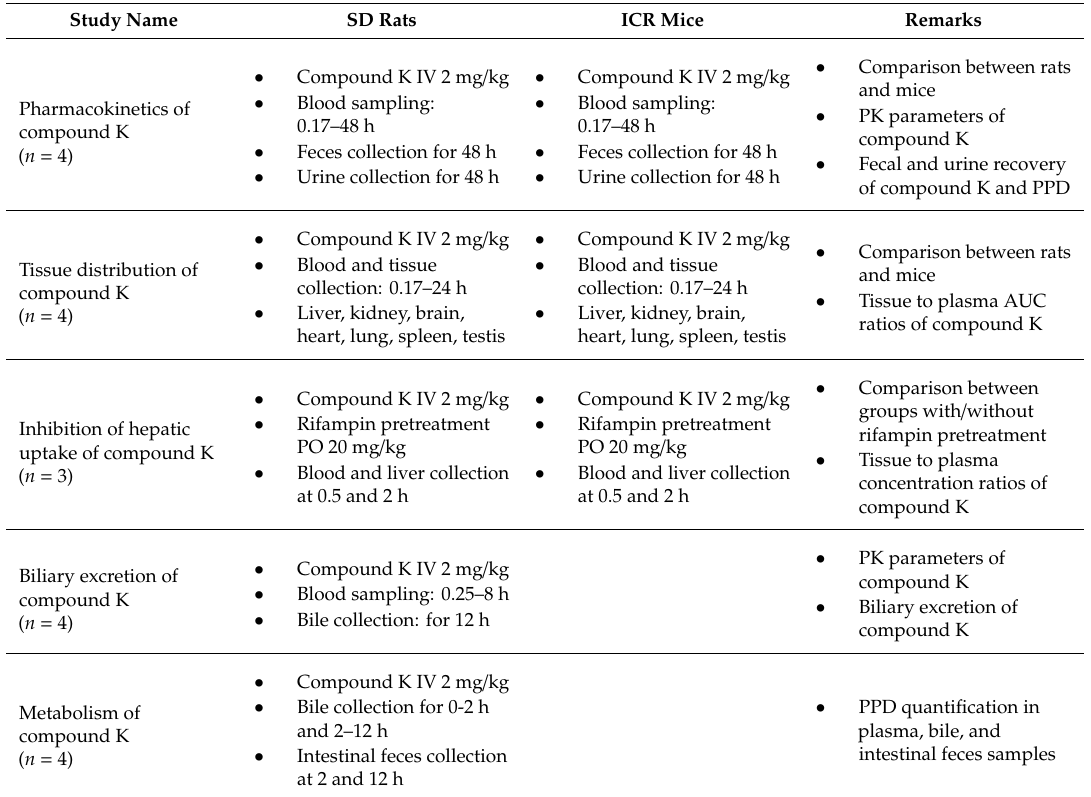
Table 1. Overview of the study design and